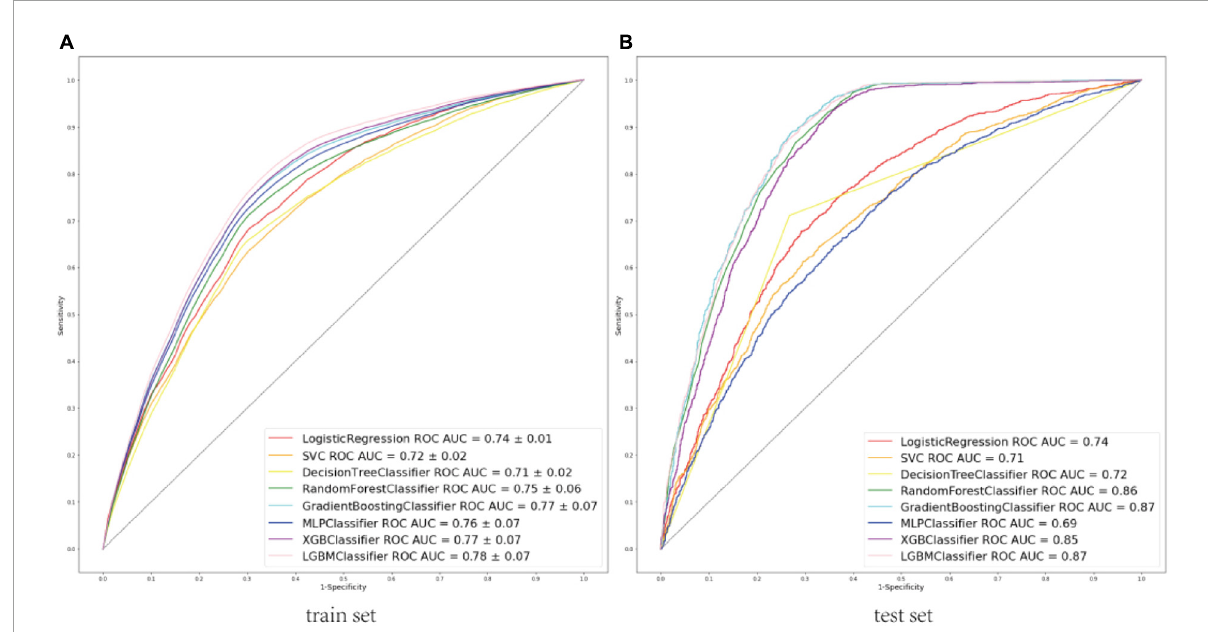
FIGURE3 (A) ROCs of eight machine learning models to predict sepsis-associated acute brain injury in train set. (B) ROCs of eight machine learning models to predict sepsis-associated acute brain injury in the test set. ROC, Receiver operator characteristic curves; AUC, area under the curve; SVC, support vector classification; MLP, multi-layer perceptron; XGB, extreme gradient boosting; LGBM, light gradient boosting